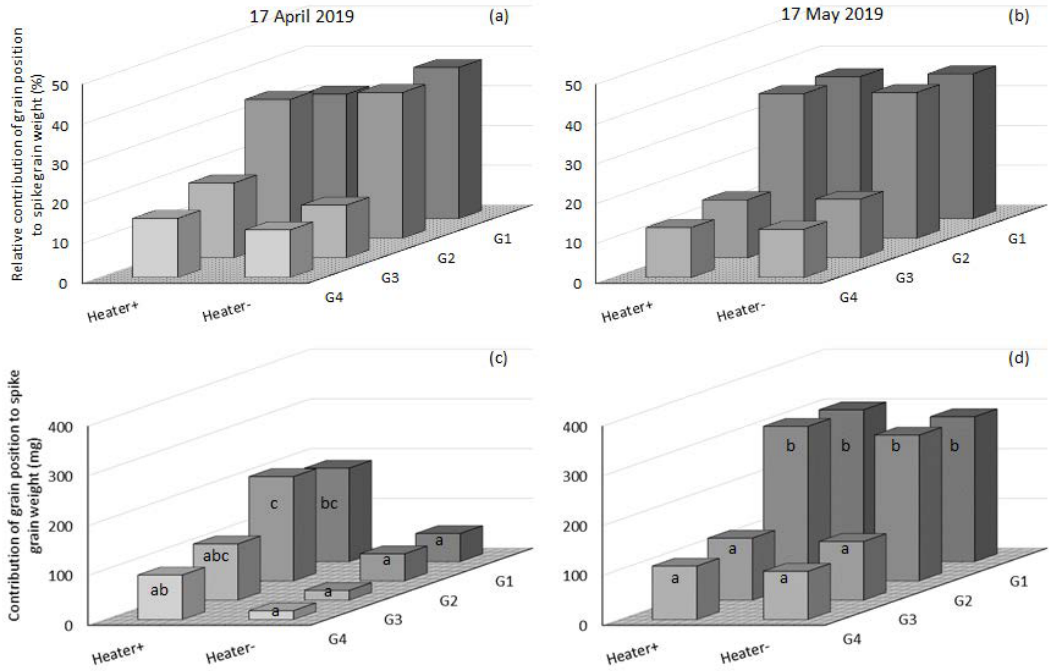
Figure 11. The relative contribution of grain at each position of the spikelet (grain position) to spike grain weight in Wyalkatchem under incidence of frost sown in mid-April (17 April 2019 ( a )) and low incidence of frost mid-May (17 May 2019 ( b )) sampled from heated and non-heated plots. Absolute spike grain weights for the same sowing dates are shown on ( c , d ) with significance ( p < 0.05) noted by different lowercase letters for each sowing date compared separately. Relative contributions are calculated from the predicted means of absolute spike grain weights ( n = 45 spikes per data